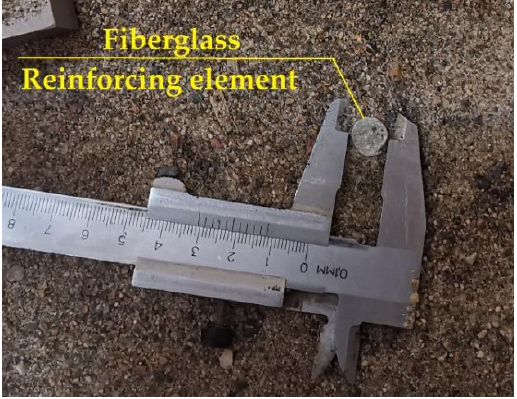
Figure 2. Location of vertical element lowered into the